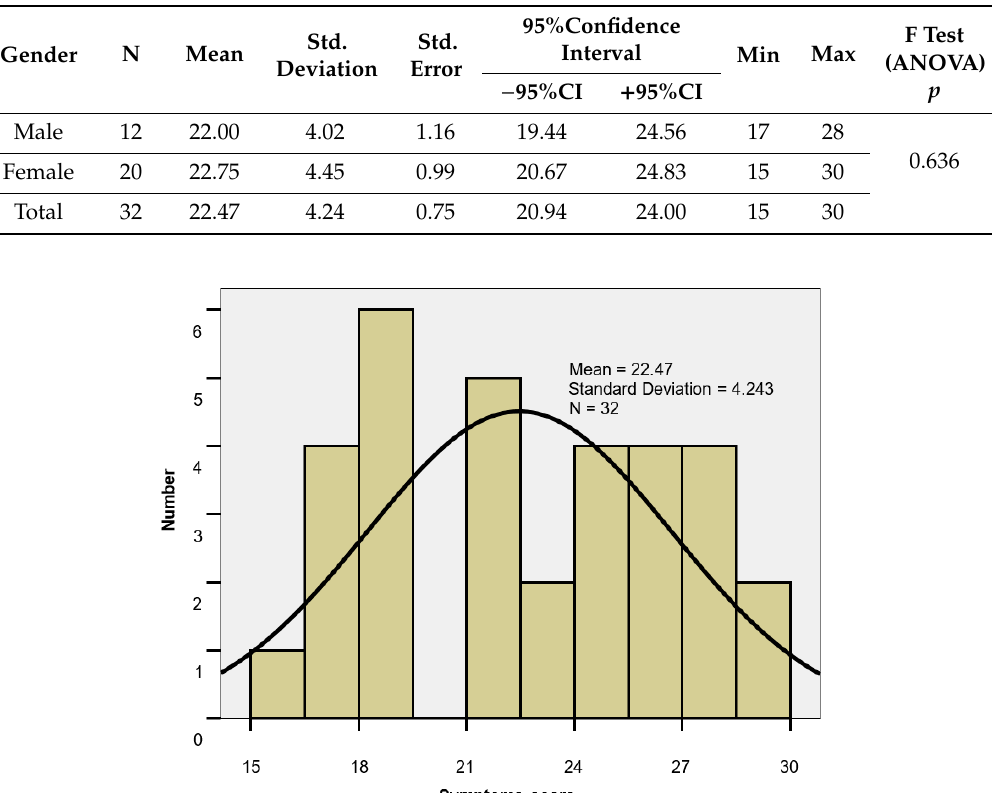
Figure 2. Symptoms score histogram.